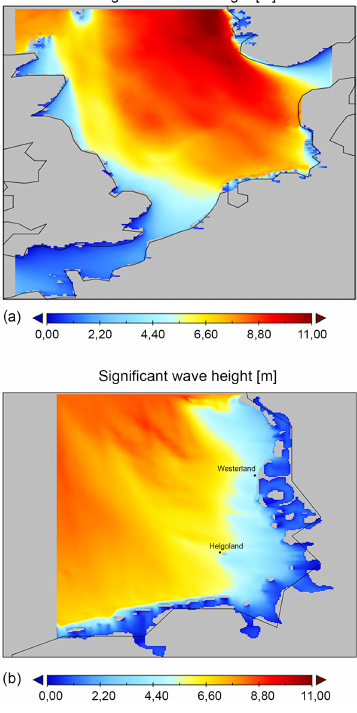
Figure 9. (a, b) Significant wave height (m) in the North Sea (a) and the German Bight (b) at the peak of storm Xaver (6 December 2013, 09:00UTC) calculated by WAM-NS/GB-2wc.